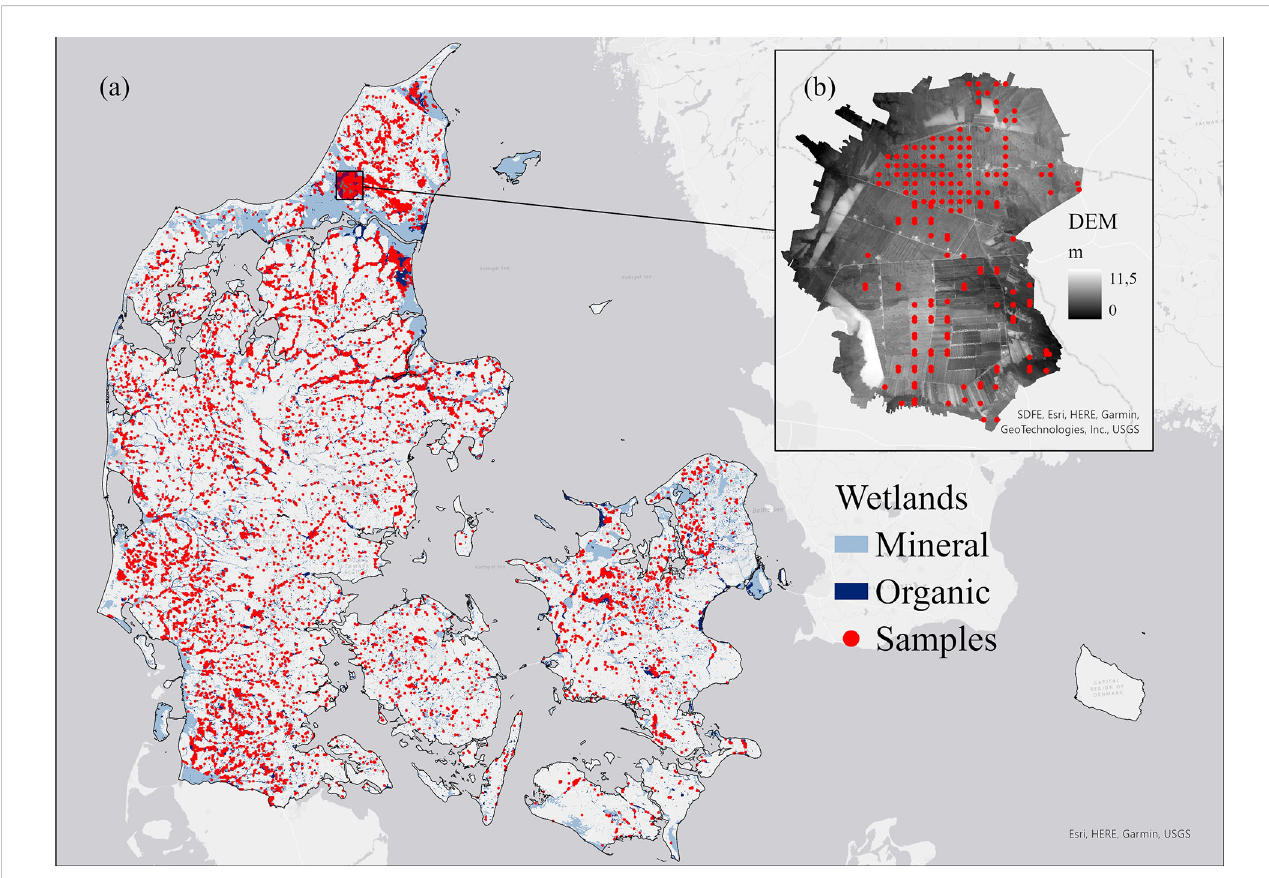
FIGURE 8 Maps showing (A) the extent of wetland areas and location of samples from the original SINKS database, and (B) the Store Vildmose raised bog area (with the digital elevation model as a background